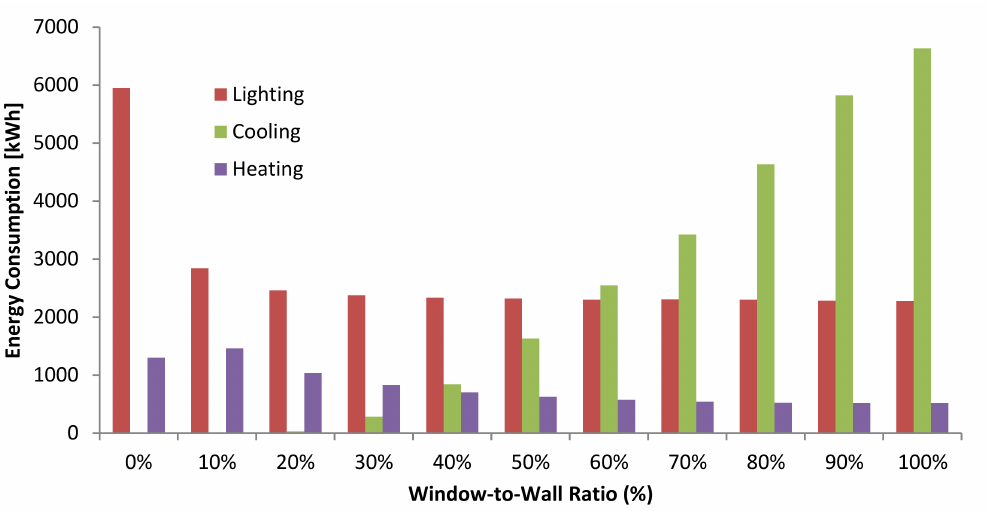
Figure 6. Annual lighting, and space heating and cooling energy consumption (kWh) for different